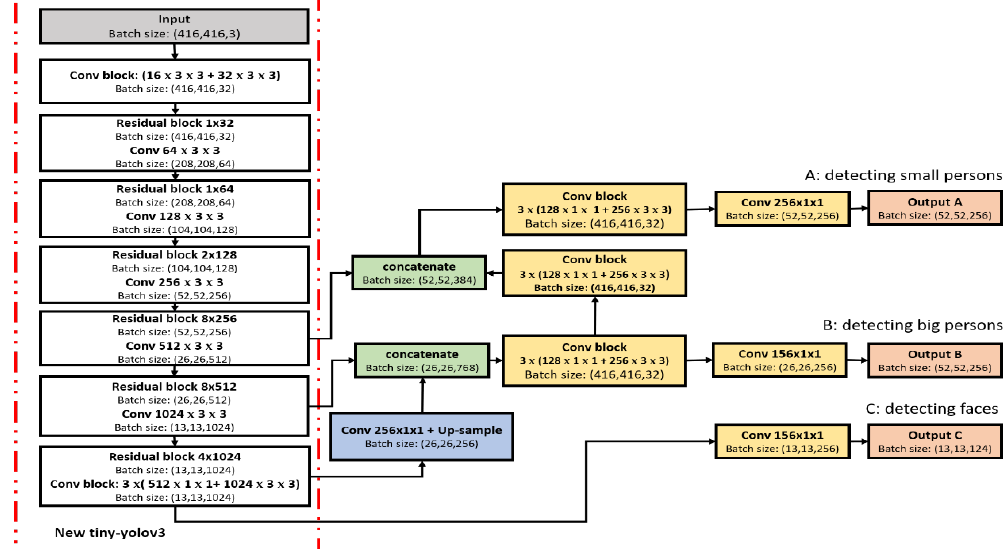
Figure 8. The new architecture of the tiny-yolov3.